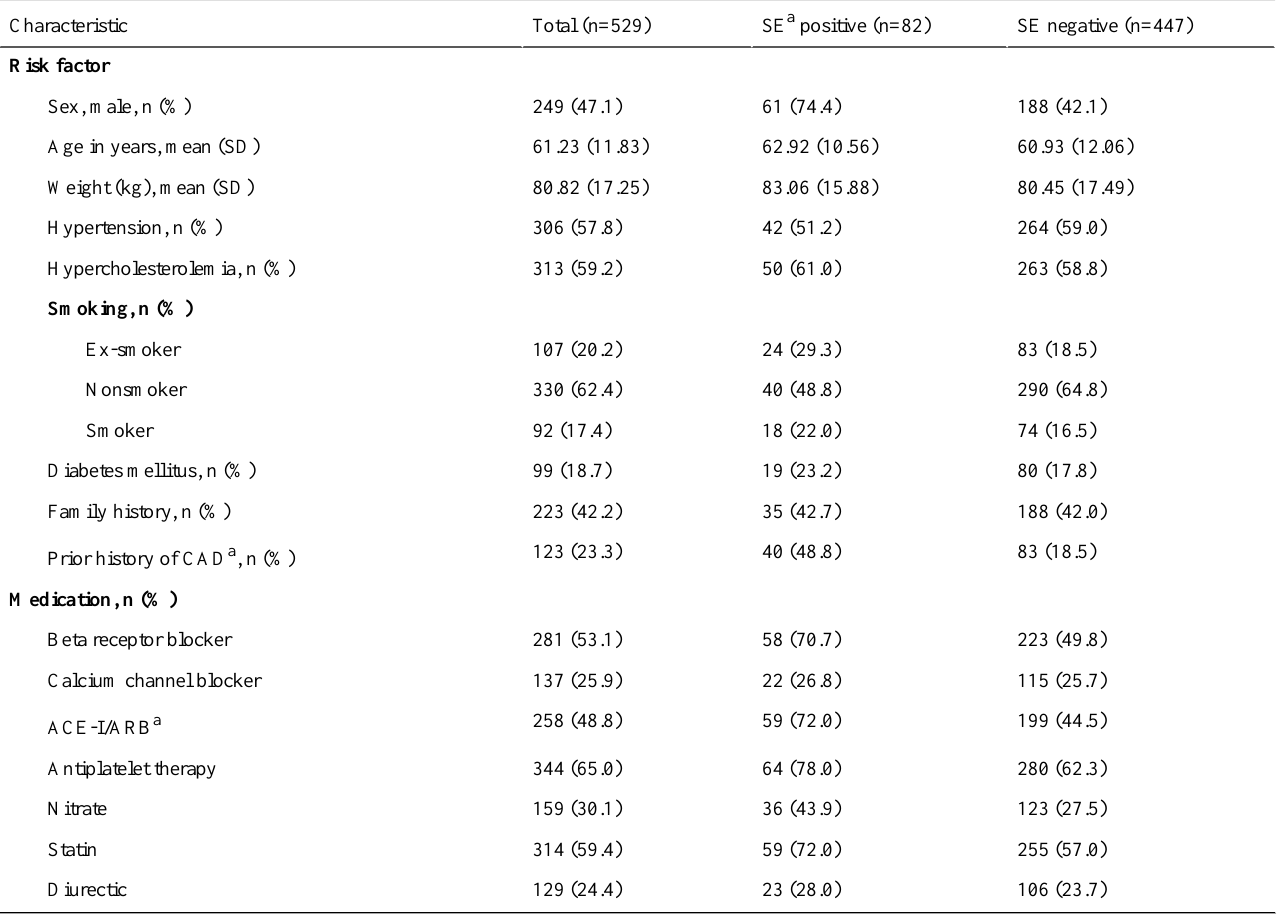
Table 1. Characteristics of patients and their stress echocardiography